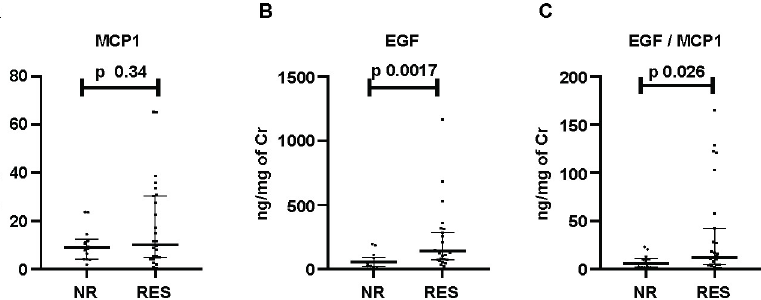
Multivariable analysis. By univariate analysis, EGF and eGFR at baseline correlated or tended to correlate with response to therapy (Fig 4) . By multivariate analysis, EGF was an independent predictor for response to therapy at 6 months. ROC curve for predicting response at 6 months. The AUC to predict response at 6 months for EGF was 0.80 (0.66–0.95) (Fig 4). The AUC for EGF/MCP1 and MCP1 were lower. EGF � 65.6 ng/mgCr gave 85% sensitivity and 71% specificity for combined response at 6 th month.